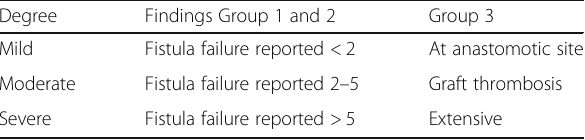
Table 2 Severity of thrombosis according to our